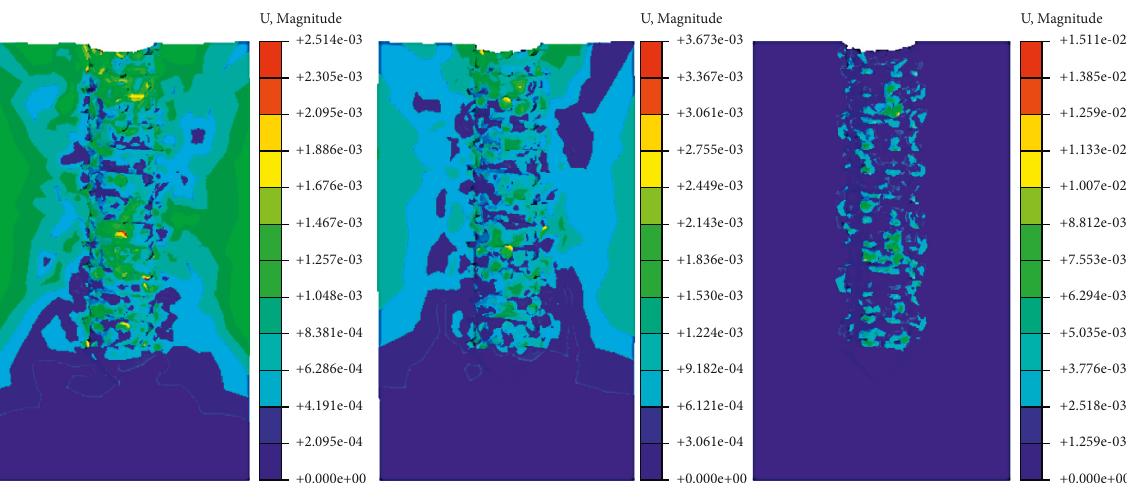
Figure 5: Bone displacement in 0.076, 0.88, and 1 seconds.